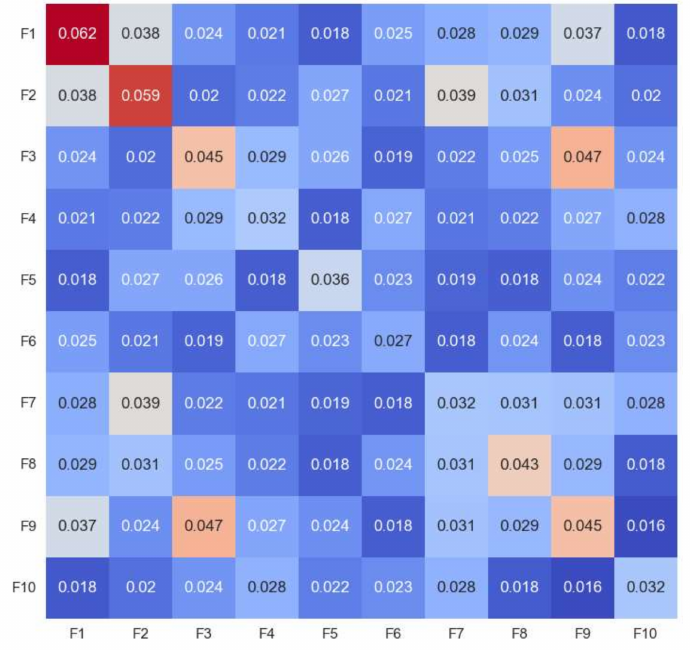
Figure 15. Absolute mean of main and interaction effects for first 10